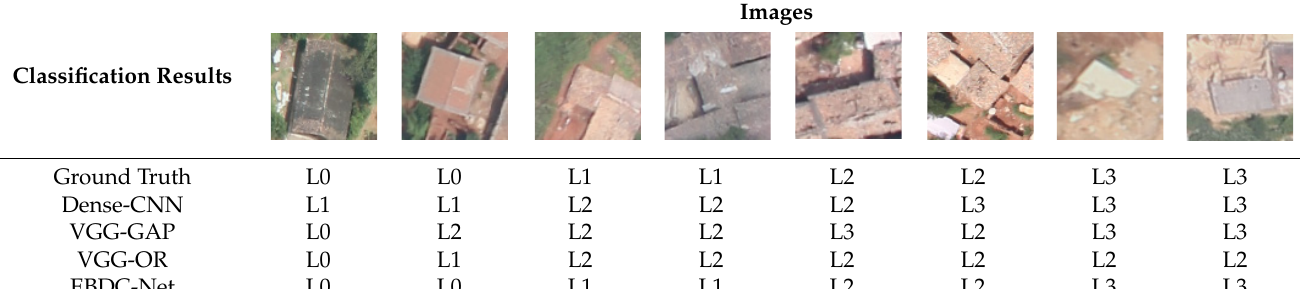
Table 12. Comparison of different methods in the refined assessment of building damage (L0: intact; L1: slightly damaged; L2: severely damaged; L3: collapsed).